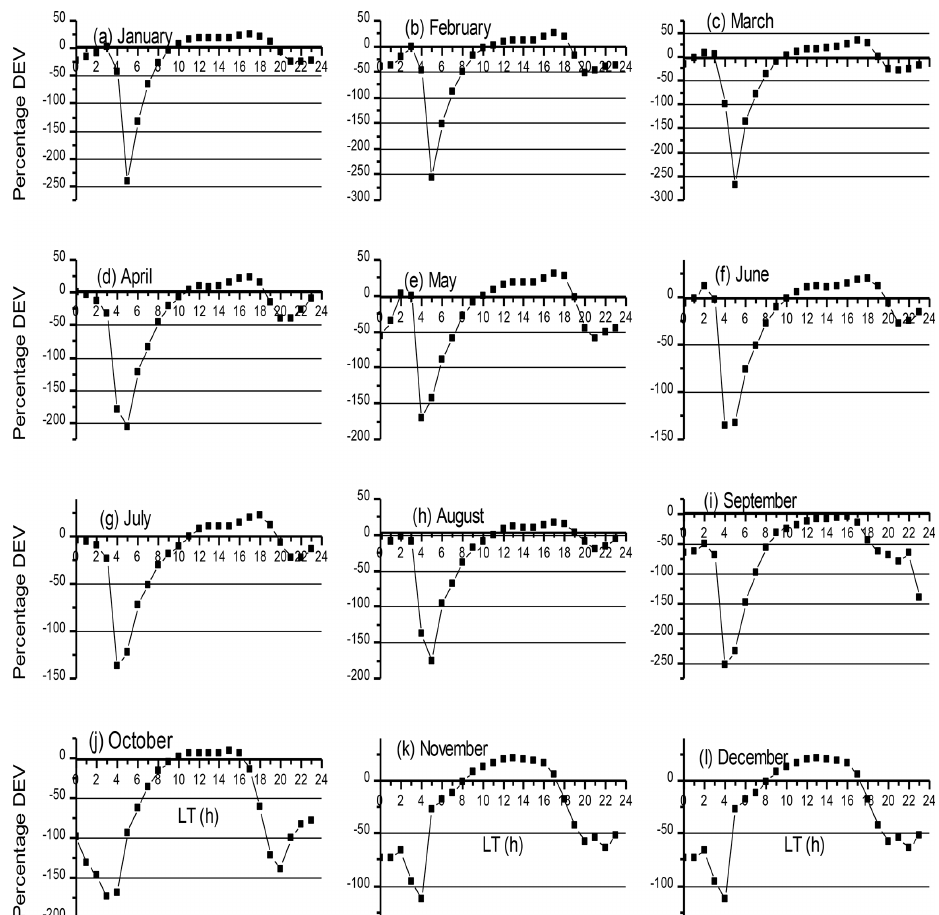
Figure 7. Percentage deviation of IRI-2016 from OBS-TEC for year 2013.